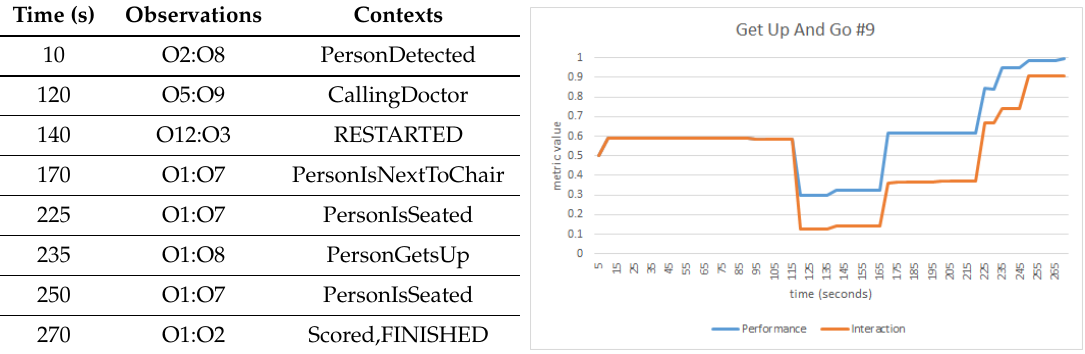
Table 7. Get Up & Go #9: (Left) Contexts and observations generated by the system. (Right) Graphical evolution of the properties values during the